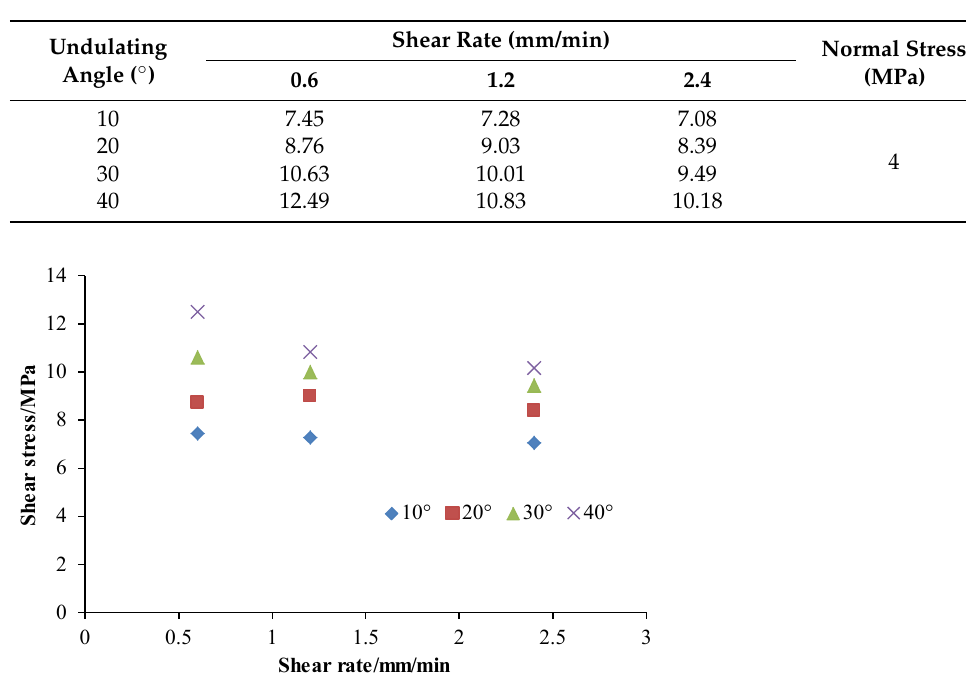
Figure 14. Relationship between shear rate and peak shear stress with different undulating angles at 4 MPa normal stress.